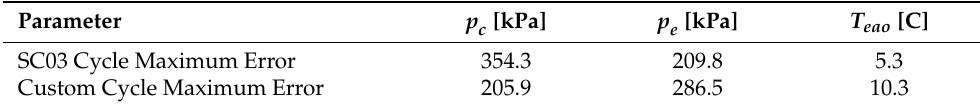
Table 3. Maximum error between VEM and NL models for SC03 and custom cycles.